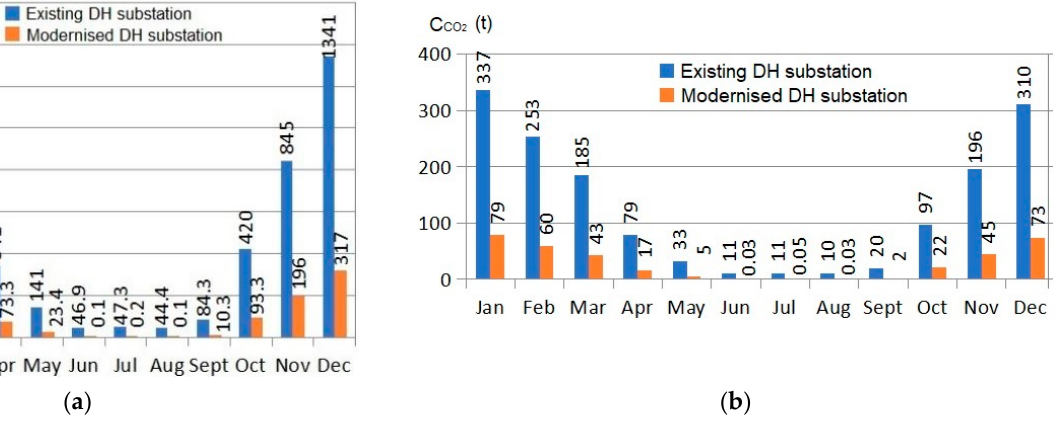
Figure 13. Annual variation in thermal energy consumption and CO 2 emissions: ( a ) Thermal energy; ( b ) CO 2 emissions. Table 6. Performances of the water-source heat pump (WSHP) systems.